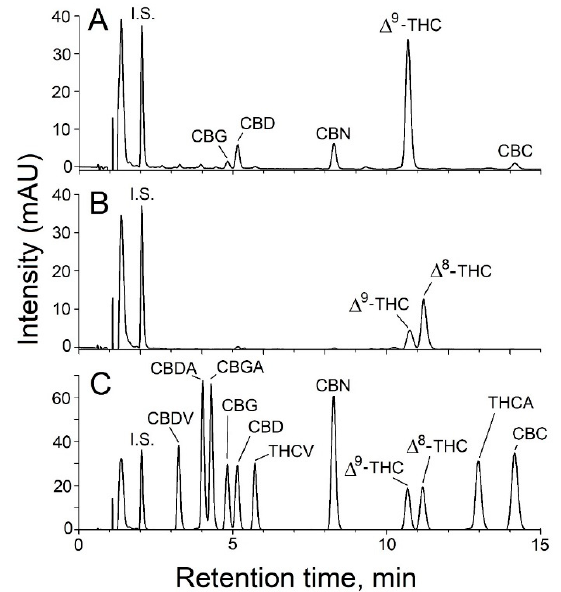
Figure 3. Analysis of cannabinoids in vaporizer fluids using HPLC-PDA. The cannabinoid profiles of vaporizer fluid in which ∆ 9 -THC is the most abundant cannabinoid ( A ) and one in which ∆ 8 -THC a vaporizer fluid in which Δ 9 -THC is the most abundant cannabinoid ( A ) and one in which Δ 8 -THC is the more abundant than ∆ 9 -THC ( B ) are shown. Chromatography of the cannabinoid standards is is the more abundant than Δ 9 -THC ( B ) are shown. Chromatography of the cannabinoid standards is shown in panel ( C ). The internal standard, norgestrel, is indicated by shown in panel ( C ). The internal standard, norgestrel, is indicated by I.S.